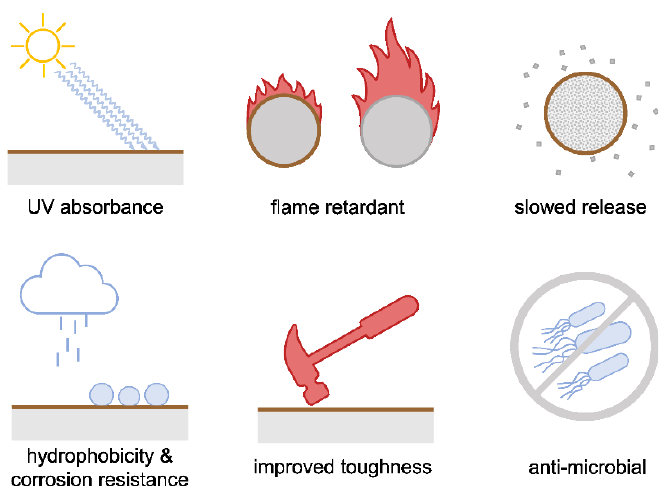
Figure 9. Lignin coatings can provide improved toughness and hydrophobicity, corrosion resistance, anti-microbial and flame-retardant properties, protection against UV-radiation, and slowed release of substrate materials.